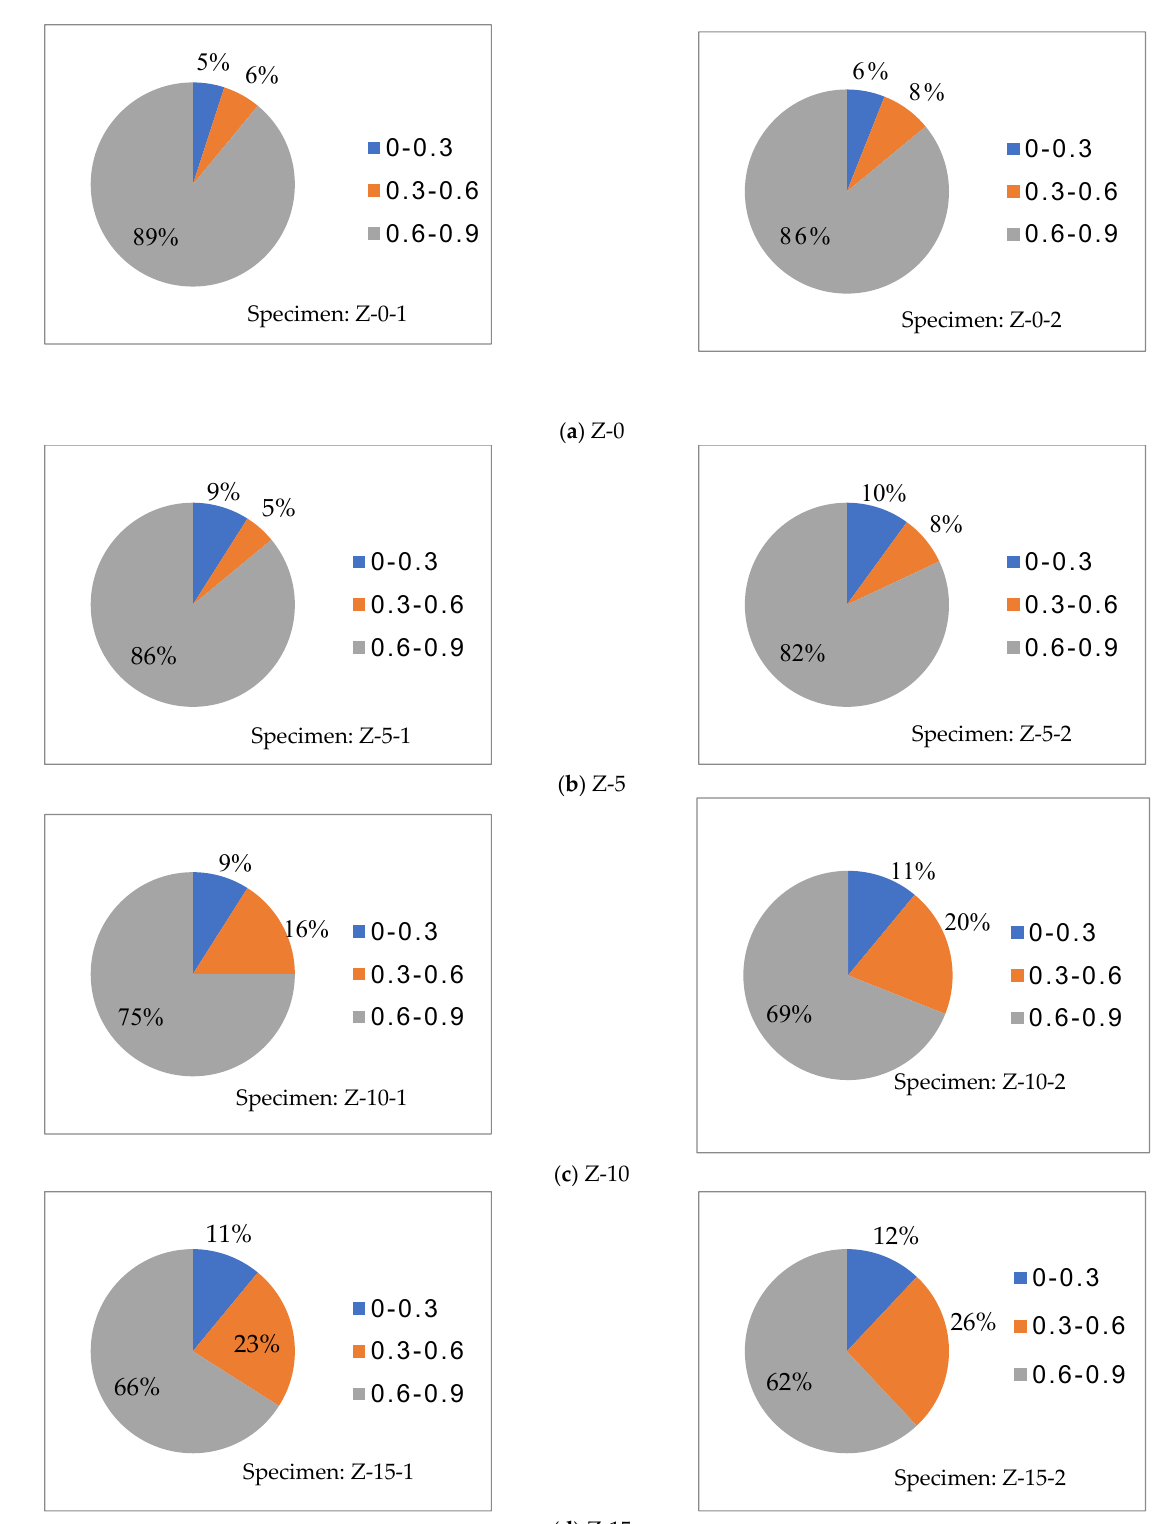
Figure 6. AE accumulative energy distribution of the reinforced concrete column for different corrosion rates (two specimens per corrosion rate) .